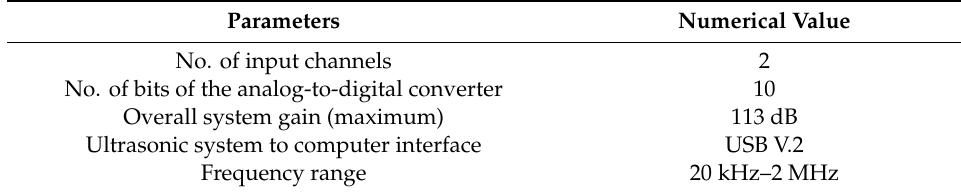
Table 2. Parameters of LF ultrasonic system